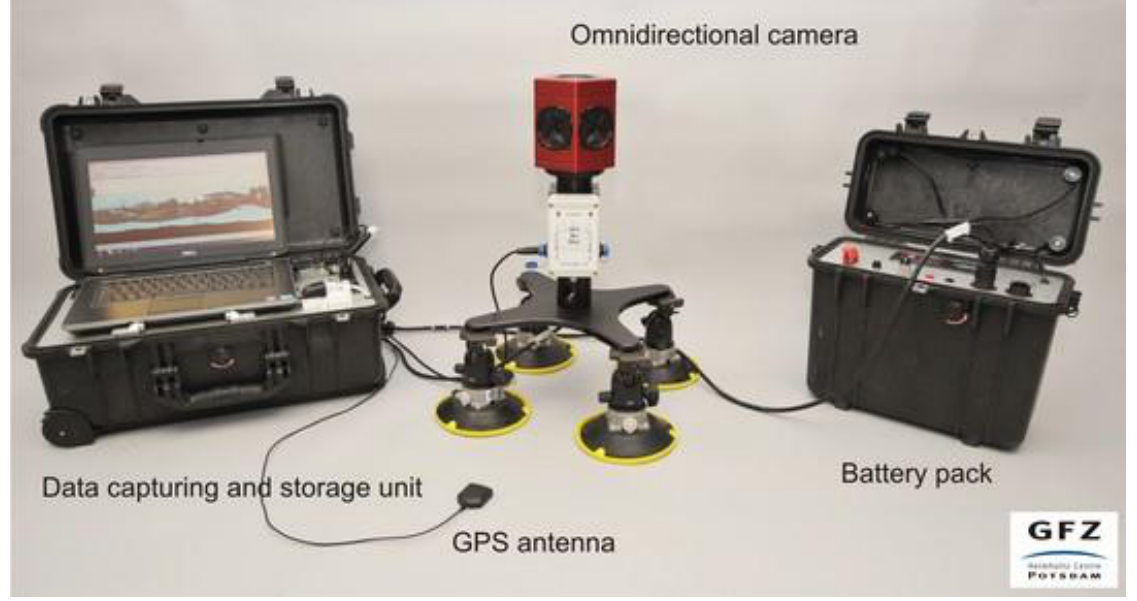
Figure 6. GFZ-MOMA omnidirectional mobile mapping system with data capturing and storage unit, and battery